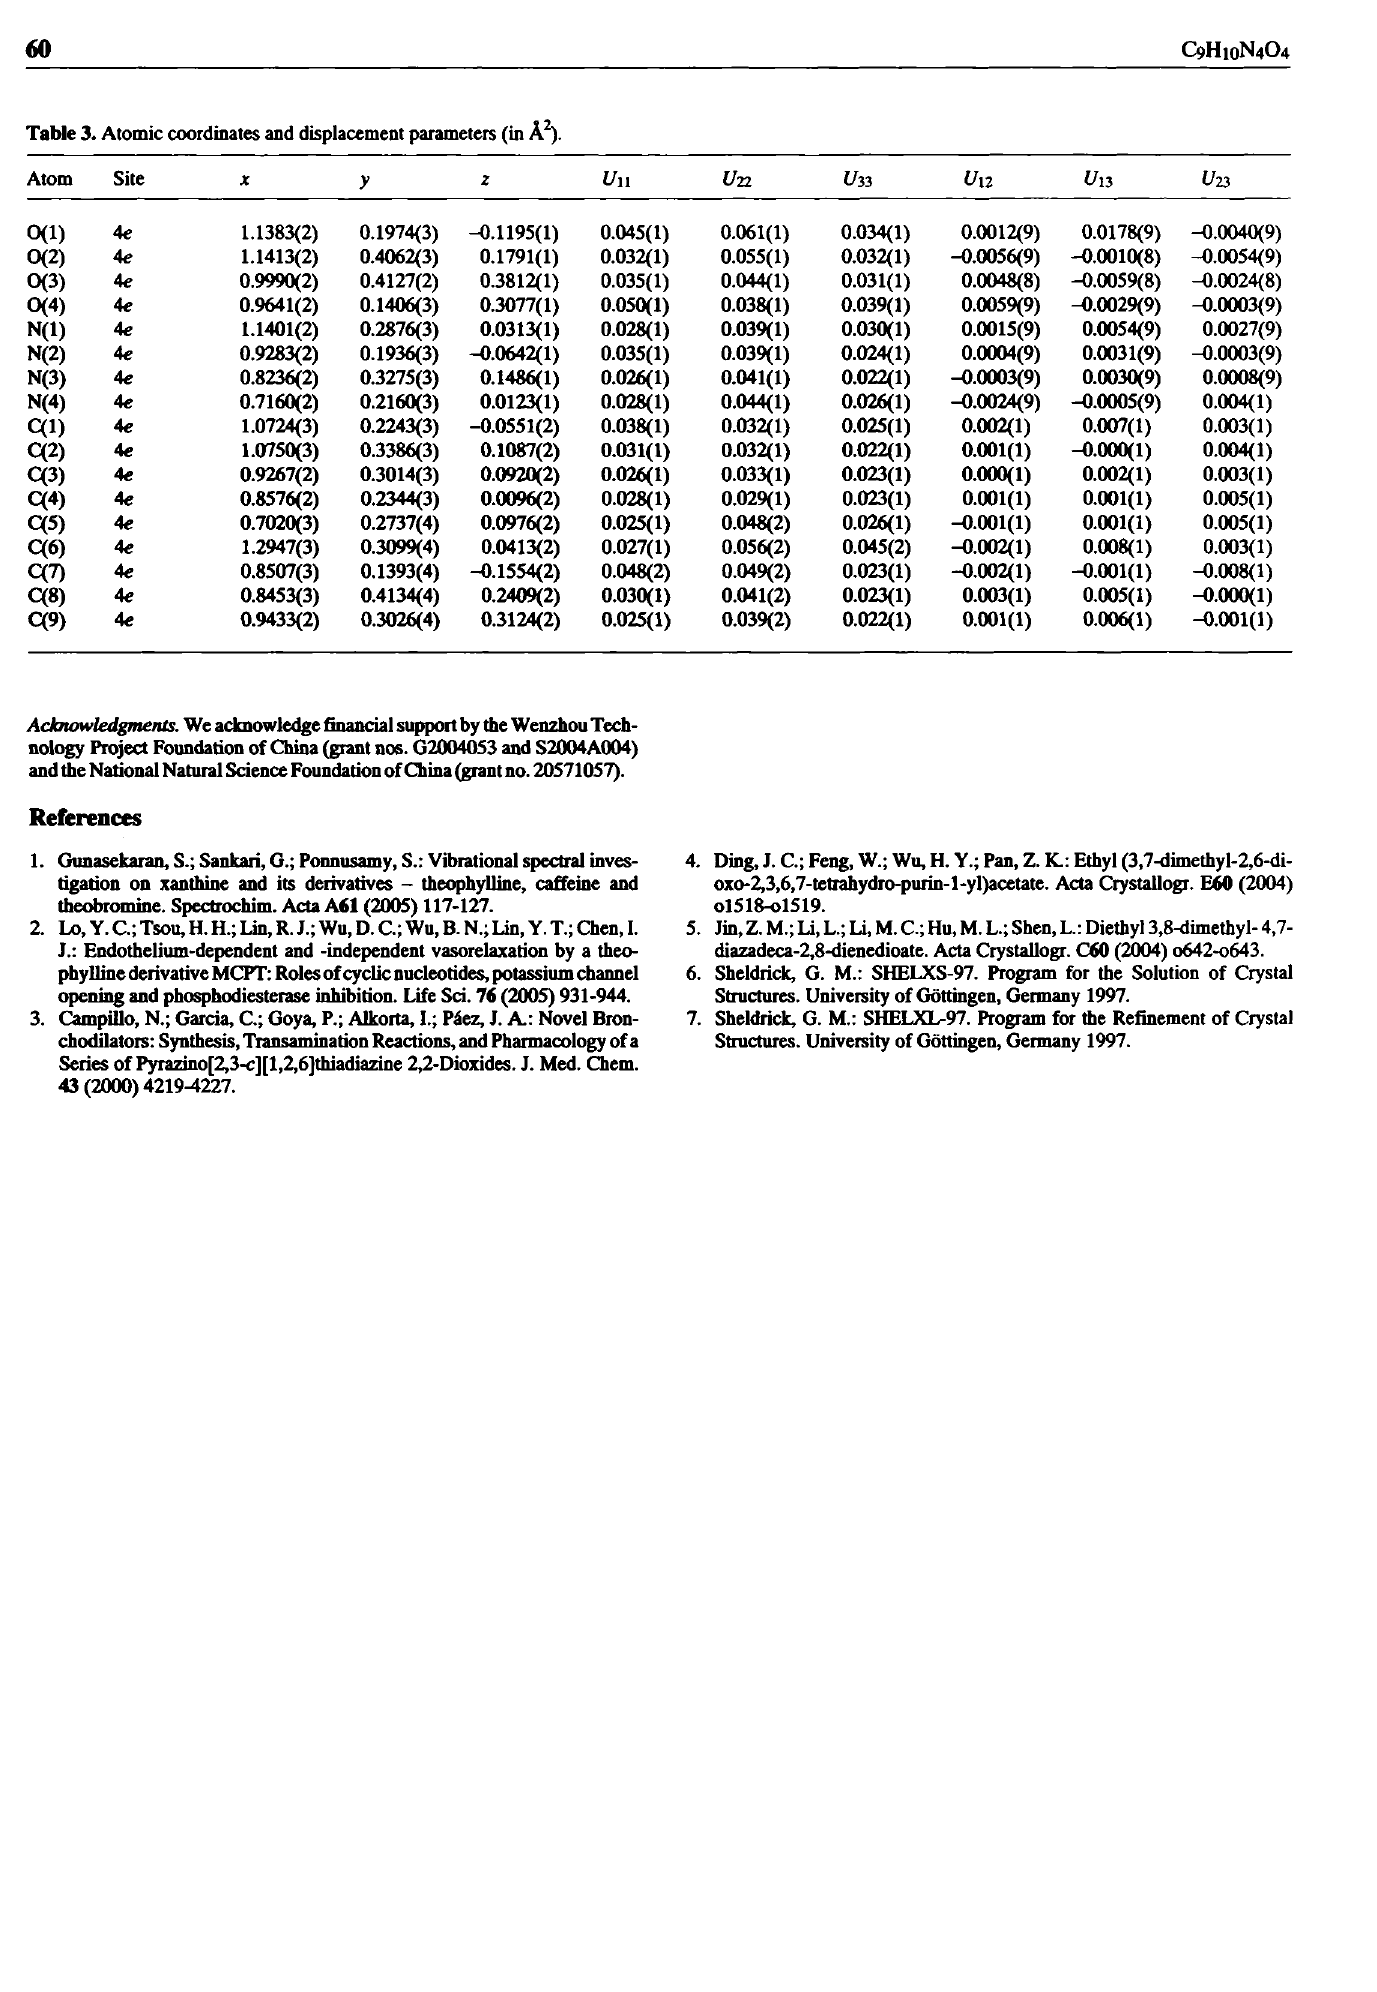
Table 3. Atomic coordinates and displacement parameters (in A 2